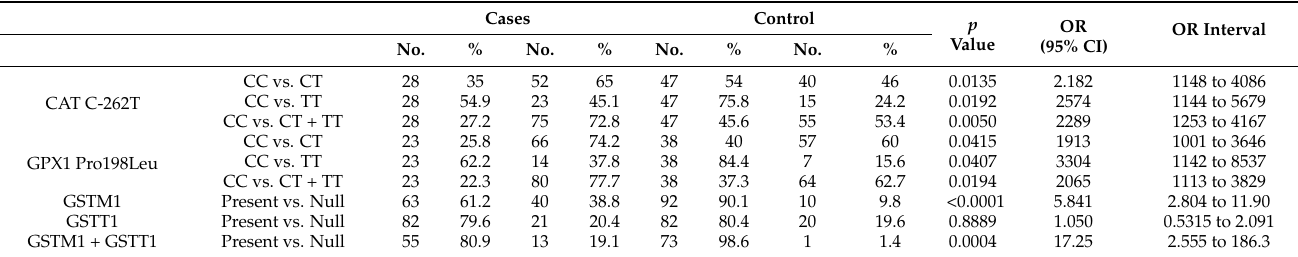
Table 1. Genotype and allele